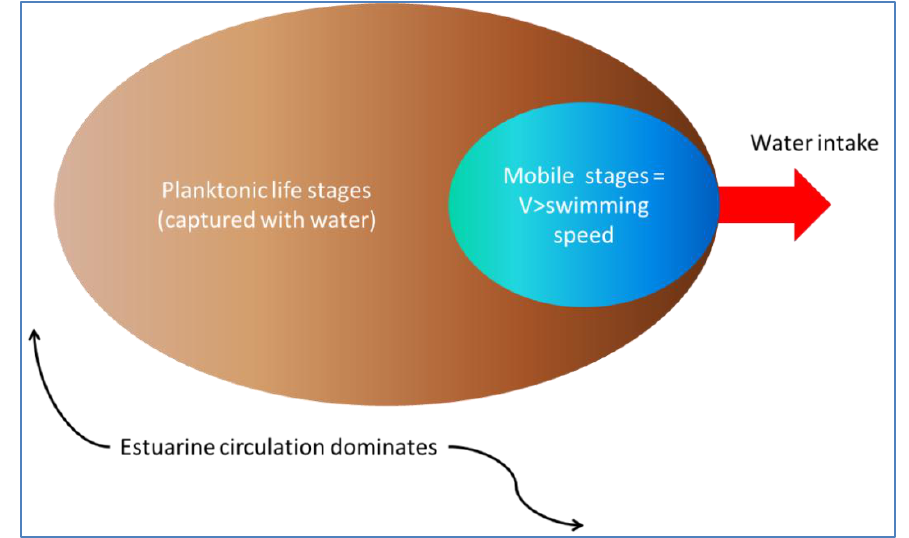
Figure 1. Conceptual model of capture zones for planktonic and mobile life